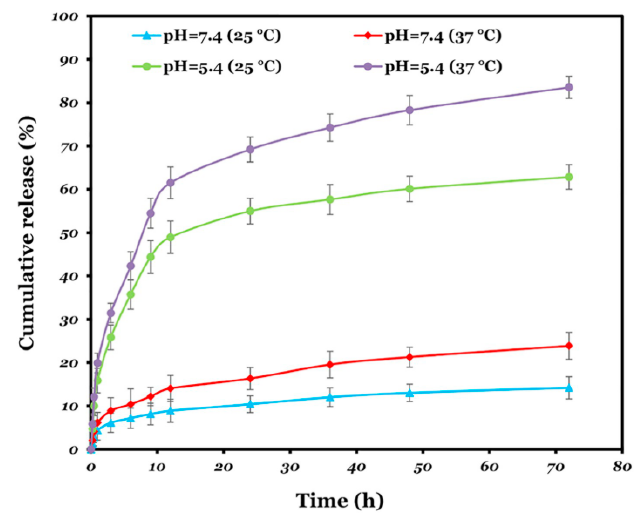
Figure 12. The cumulative release of doxorubicin: blue: pH 7.4 and 25 °C, green: pH 5.4 and 25 °C, red: pH 7.4 and 37 °C, and purple: pH 5.4 and 37 °C [114]. Reprinted from Materials Science and